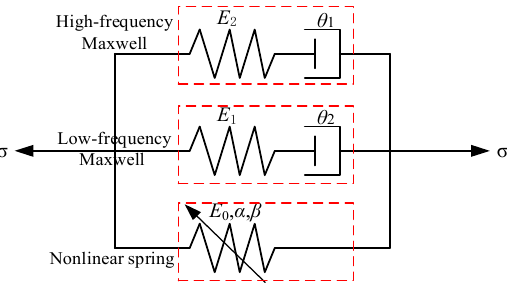
Figure 12. The rheological form of the ZWT model.